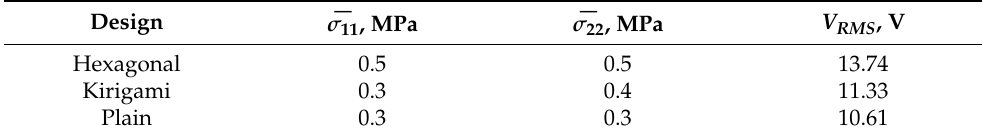
Table 5. Voltage output and longitudinal as well as transverse stresses for all simulated models. Design